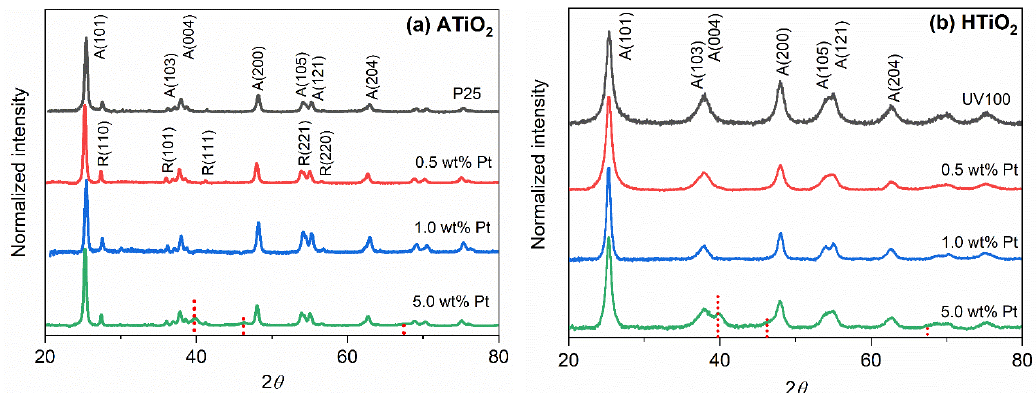
Figure 1. XRD patterns of pristine and different percentage of Pt loaded on ( a ) ATiO 2 and ( b ) HTiO 2 surfaces. A and R stand for anatase and rutile phases, respectively. The red lines in the bottom represent the Pt reference. As revealed from Figure 1 and Table 1, the loading of Pt nanoparticles does not sig ‐ nificantly change the XRD pattern position or features for all Pt ‐ TiO 2 samples, indicating that the preparation method did not significantly change the phase content and the crys ‐ tallinity of the TiO 2 . Notably, the deposition of Pt did not generate any typical Pt diffrac ‐ tion peaks, which might result from the uniform distribution and the low loading amount of Pt [27]. However, in the 5.0 wt% Pt ‐ loaded samples, two weak and broad peaks around 39.8° and 46.2° corresponding to 111 and 200 fcc platinum metal, respectively, have been observed. The DR UV–vis spectra of pristine and platinized ATiO 2 and HTiO 2 samples were converted to their corresponding Tauc plots and shown in Figure 2. All the tested powders exhibit a similar optical bandgap of ~3.0 eV for ATiO 2 anatase ‐ rutile polymorph (Figure 2a) and ~3.2 eV for the ATiO 2 anatase polymorph (Figure 2b) [28]. The absorption spectra for Pt ‐ TiO 2 samples indicate that the photodeposition method does not induce a substan ‐ tial variation of the bandgap energy, however, a slight shift to the visible light region has been observed, due to the color change and high absorption of platinum clusters in the visible region [29]. This optical characteristic of Pt ‐ TiO 2 indicated that Pt nanoparticles do not exhibit localized surface plasmon absorption in the visible region, which can be at ‐ tributed to a damping effect caused by d–d interband transitions [27]. Figure 2. Normalized diffuse reflectance spectra (Tauc plot vs. photon energy) of pristine and platinized samples for ( a ) ATiO 2 and ( b ) HTiO 2 .